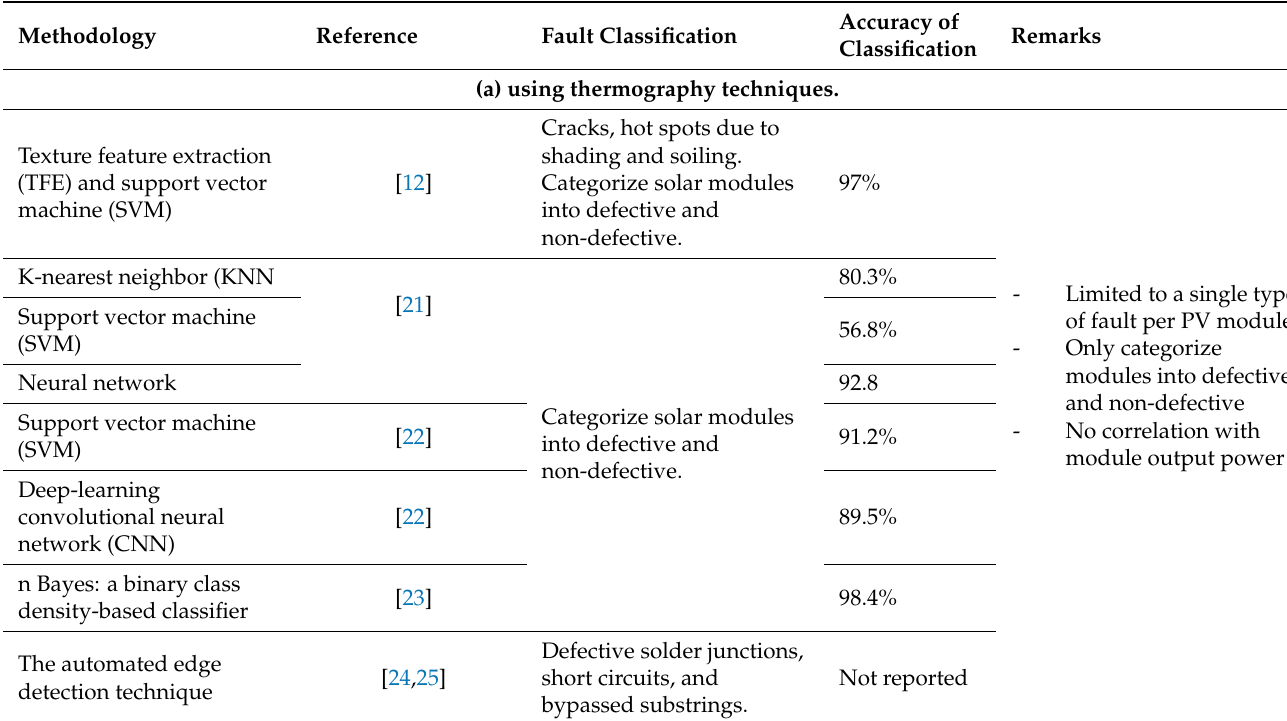
Table 1. An overall review of using AI techniques for fault detection and diagnosis in PV plants.